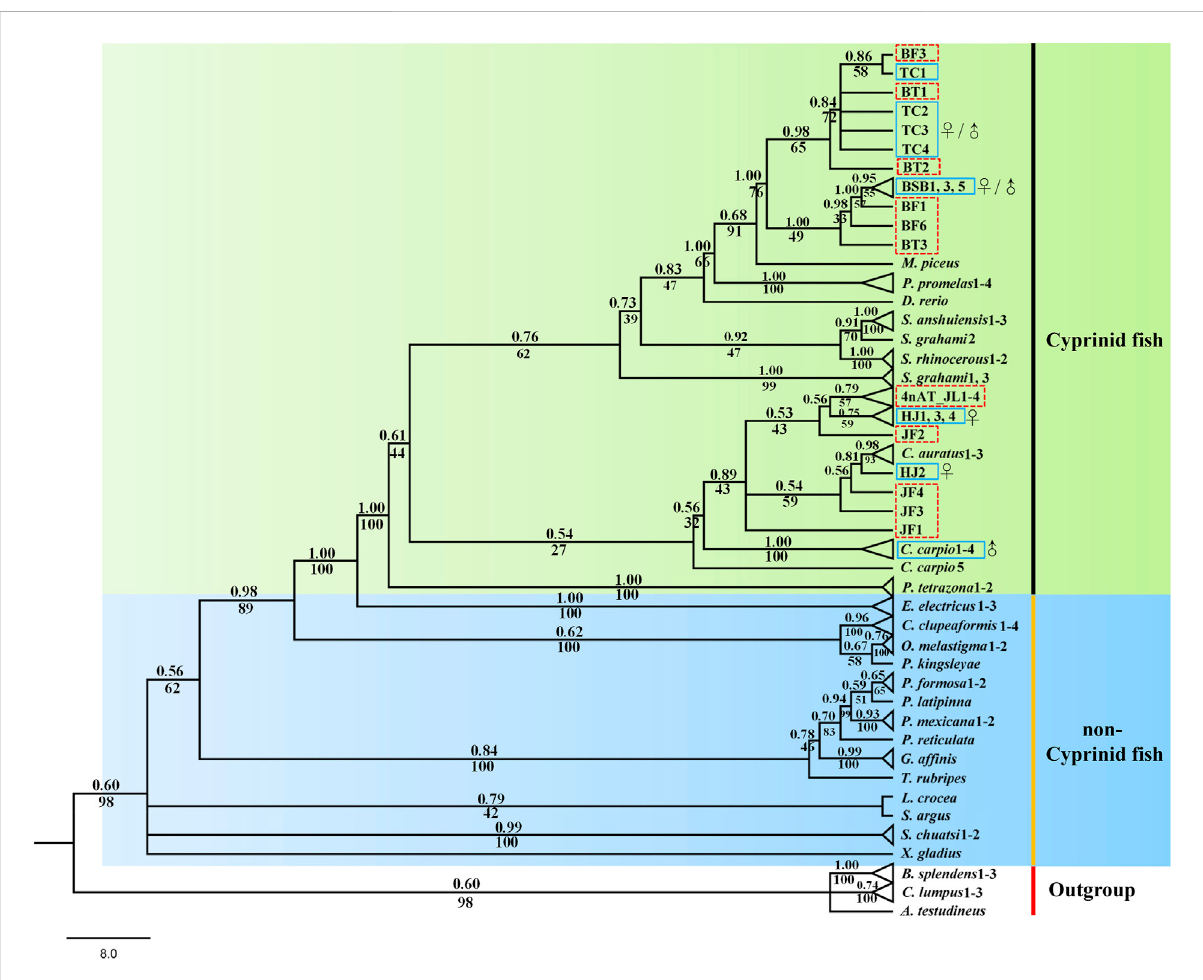
FIGURE 5 Phylogenetic tree based on Bayesian inference using the concatenate sequences ( dlx2b + dlx4b + dlx5a + pitx2 + fth1b + scpp5 ); values on branches indicate Bayesian posterior probabilities and bootstrap proportions from a maximum likelihood analysis. The blue solid line means the parents, and the red dotted line means the distant hybrids in the present study. \ means female parent, and _ means male